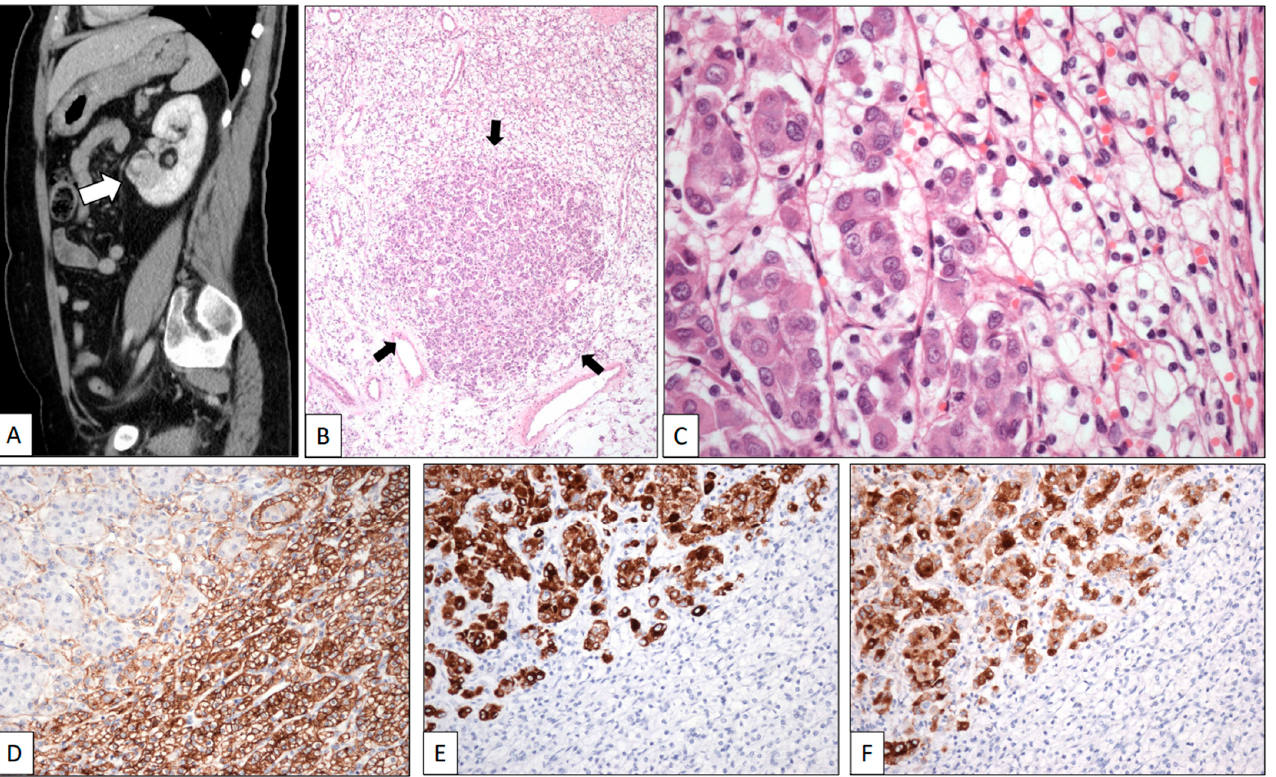
Figure 1. Clear cell renal cell carcinoma metastasized by breast carcinoma. ( A ) Sagittal CT scan shows a tumor in the lower pole of the left kidney (white arrow). Low-power view of one of the multiple metastases of the surgical specimen showing a nest of eosinophilic cells (black arrows) in a background of clear cells ( B ). High-power detail of a micrometastasis (arrows) showing large eosinophilic cells of breast carcinoma intermingled with small clear cells of renal cell carcinoma ( C ). The immunohistochemical profile of the two components displays positive staining with CD10 ( D ) in the clear cell renal cell carcinoma whereas breast cancer cells were positive with CK19 ( E ) and GCDFP-15 ( F ).